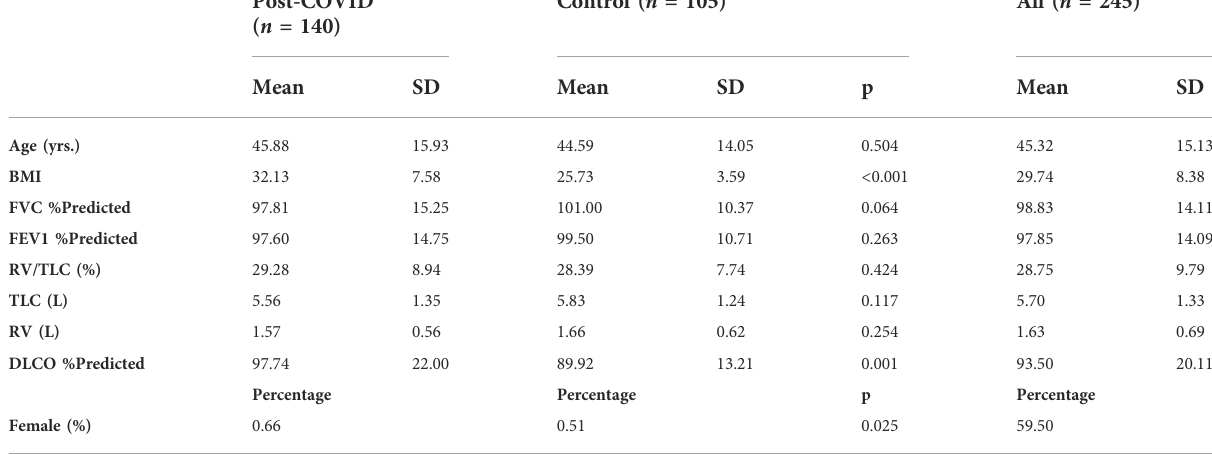
TABLE 1 Demographic and PFT data for all the